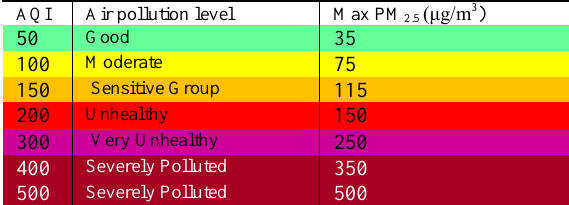
Table 3. AQI and air pollution levels with corresponding PM 2.5 concentrations (Ministry of Environmental Protection of People’s Republic of China)